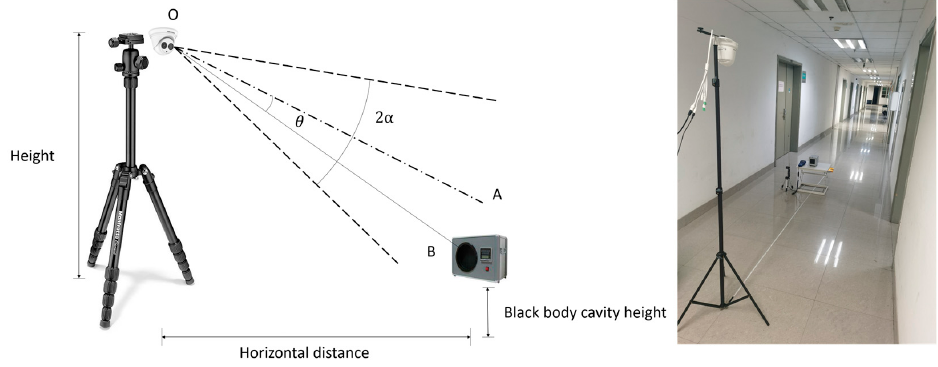
Figure 1. The setup and the schematic graph of the laboratory experiment.